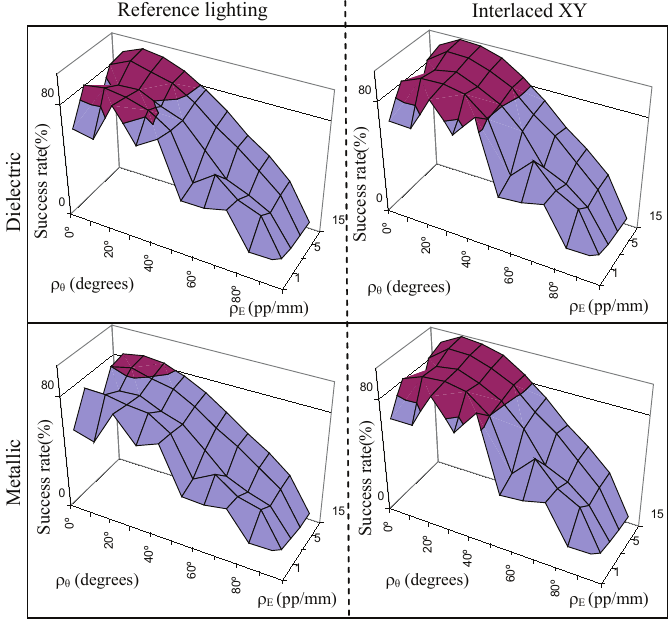
Figure 15. Success rates for the dielectric and metallic surfaces according to lighting of reference and the transformation Υ Φ with best results (‘ Interlaced XY